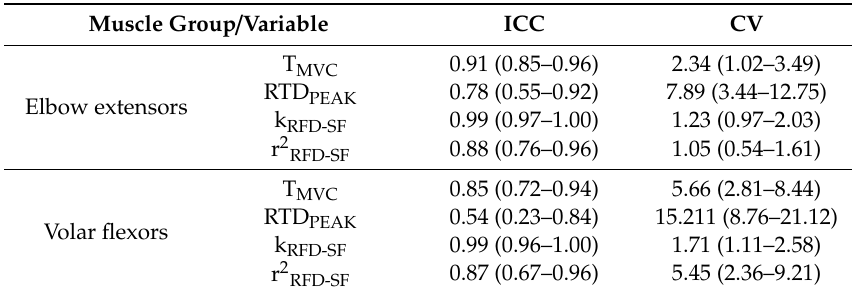
Table 2. Reliability of the outcome